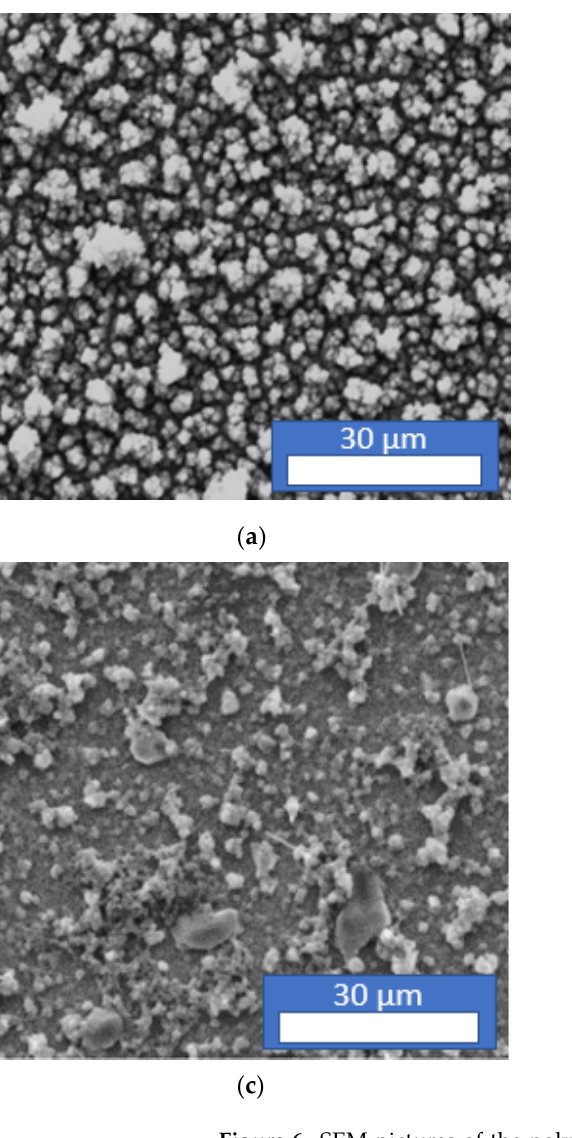
Figure 6. SEM pictures of the polymer films resulting from the electro-oxidation of 95:5 Cz:CzA ( a ), 70:30 Cz:CzA ( b ), 50:50 Cz:CzA ( c ), and 5:95 Cz:CzA ( d ) solutions. Polymers with a Balanced Portion of Cz and CzA